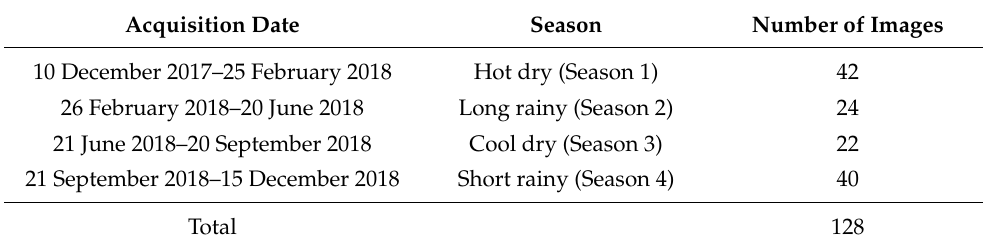
Sentinel-2 multispectral data acquisition dates and their specific seasons of the